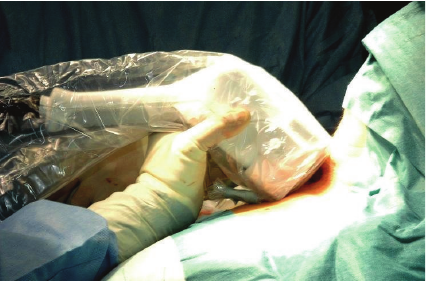
Figure 1: Intraoperative scans acquisition.